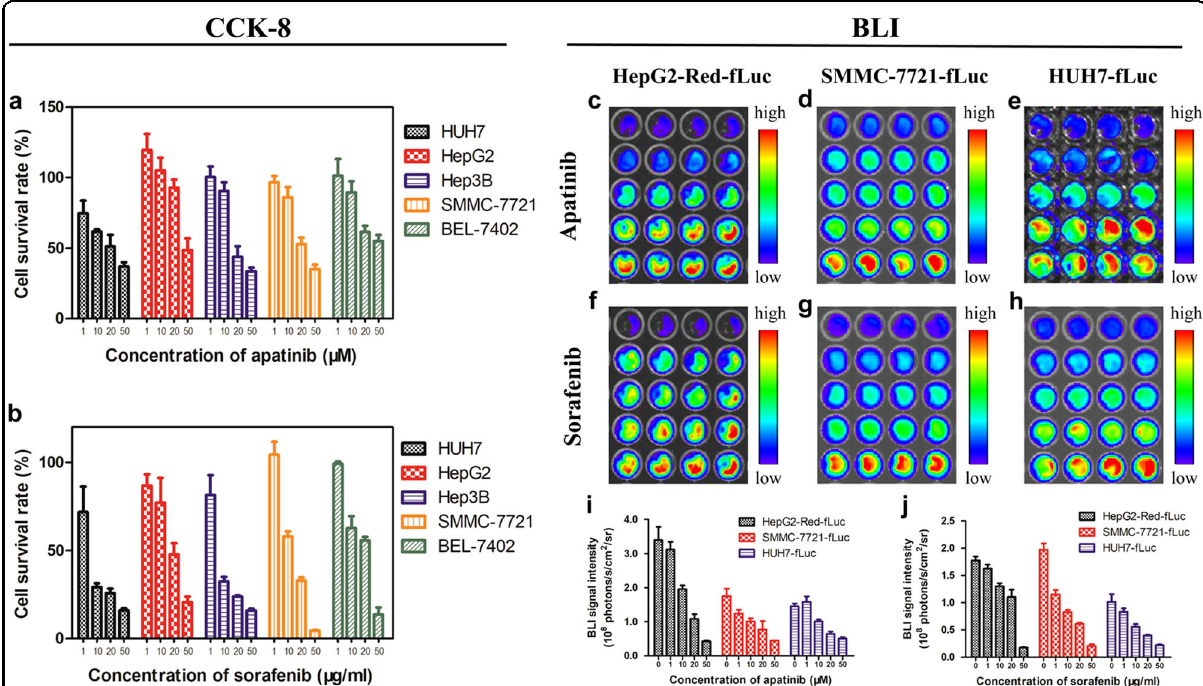
Fig. 1 HCC cell viability at different concentrations of apatinib and sorafenib, as evaluated by CCK-8 assays and BLI after 24 h of drug administration. a CCK-8 assays of the apatinib and ( b ) sorafenib treatment groups. ( c – h ) BLI images. ( i, j ) Quanti fi cation of BLI signal intensity